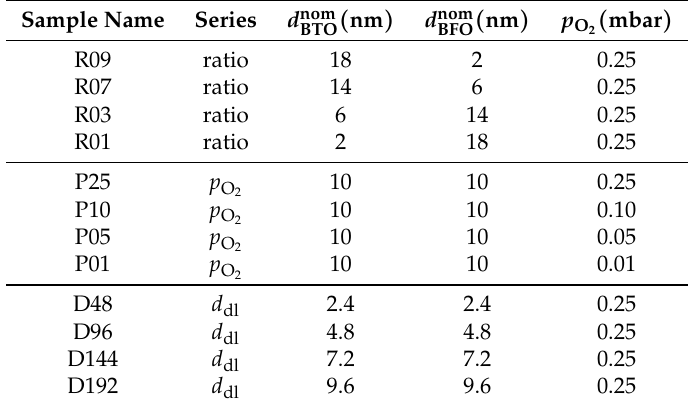
Table 1. Samples used in this study. Naming schemes: R0 X —nominal thickness ratio 0. X = d BTO / d dl